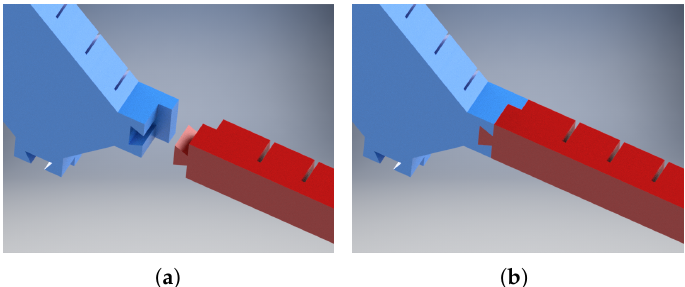
Figure 2. CAD model of a dovetail connection for FEAs: ( a ) unconnected; and ( b ) connected (blue: main body; red: